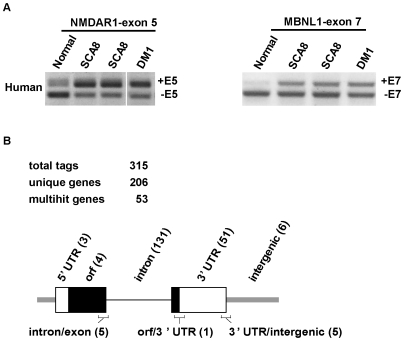
Alternative splicing changes in SCA8 and CUGBP1 RNA targets.(A) RT-PCR of human autopsy tissue showing alternative splicing changes previously reported for DM1, NMDAR1 (exon 5) and MBNL1 (exon 7) also occur in SCA8. B) Diagram summarizing relative position of CUG-BP1 CLIP tags in genes. Boxes = exons (open = UTR; black-ORF); thick grey line = intergenic regions. Also indicated are tags that overlap intron/exon, orf/3′ UTR and 3′ UTR/intergenic junctions with the number of unique tags for each location in parentheses.